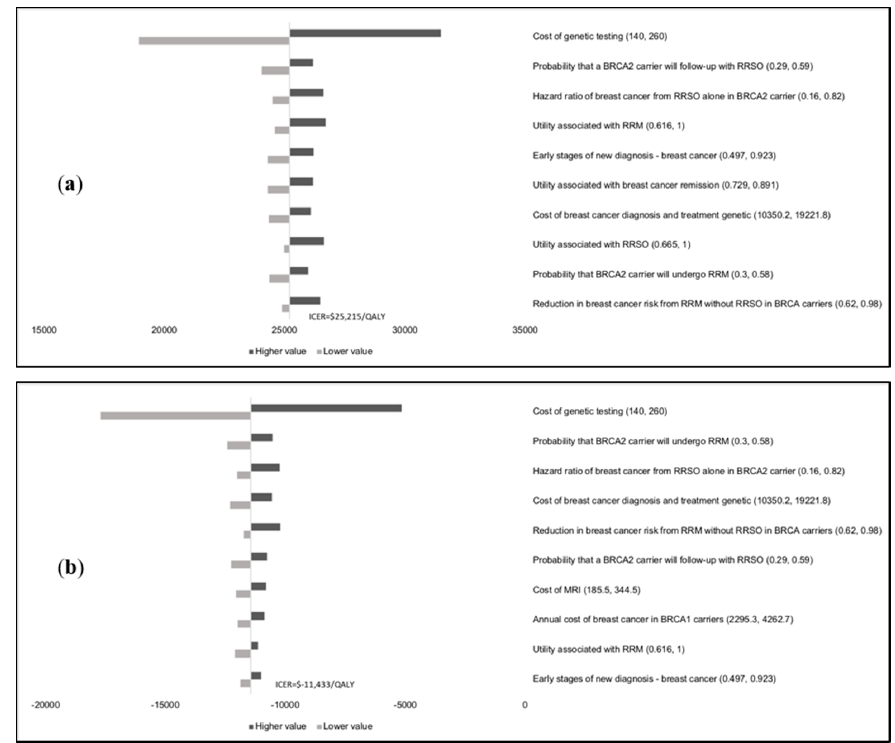
Figure A3. Tornado Diagram in the Netherlands ( a ) from the healthcare payer perspective. ( b ) from the societal perspective.